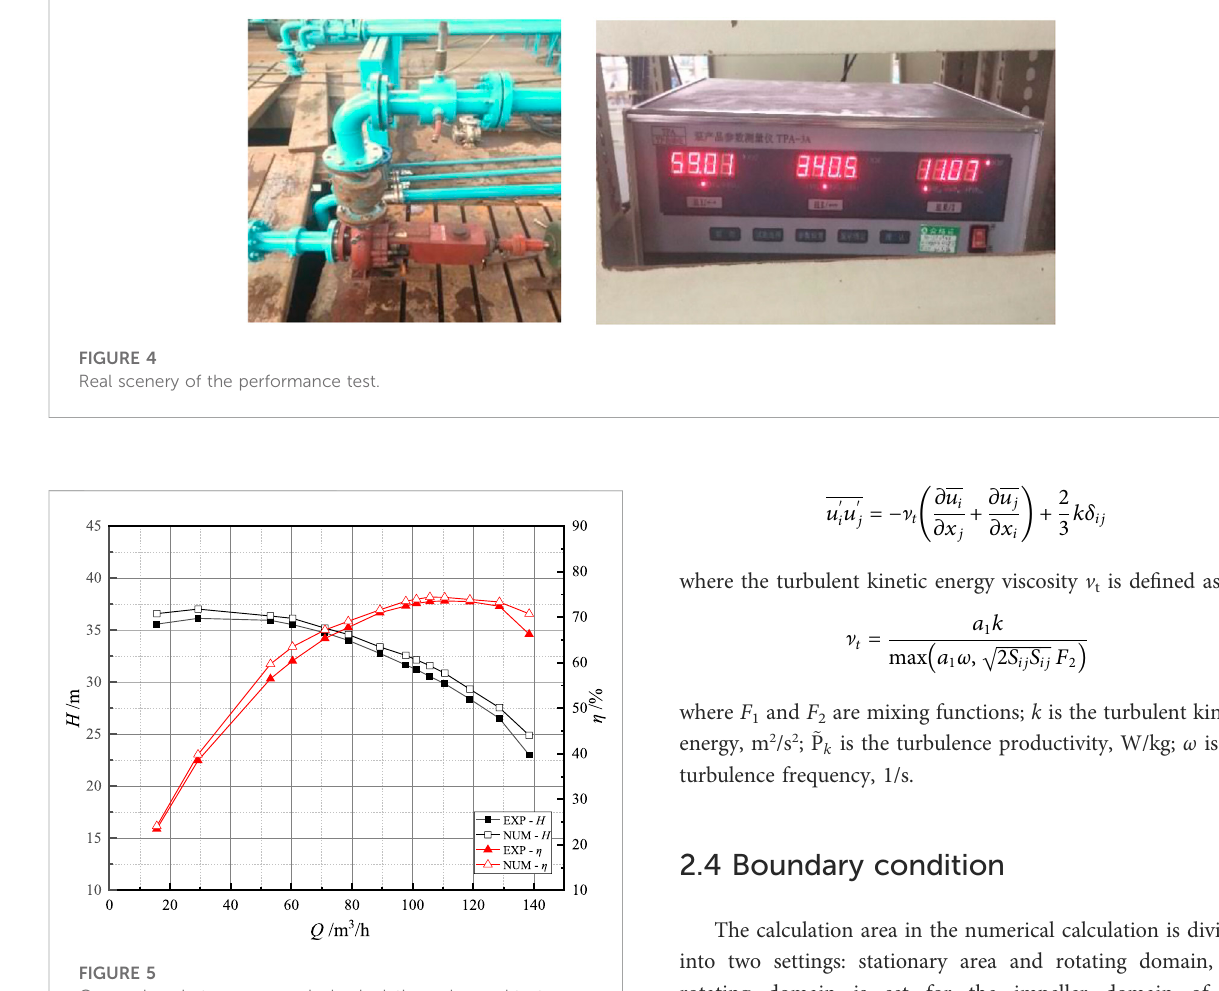
FIGURE 5 Comparison between numerical calculation value and test